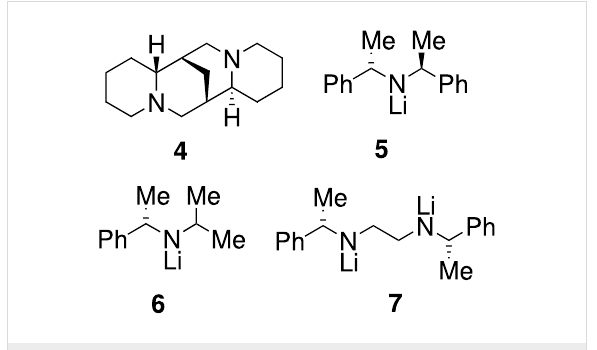
Figure 1: The diamine (-)-sparteine and three chiral lithium amide